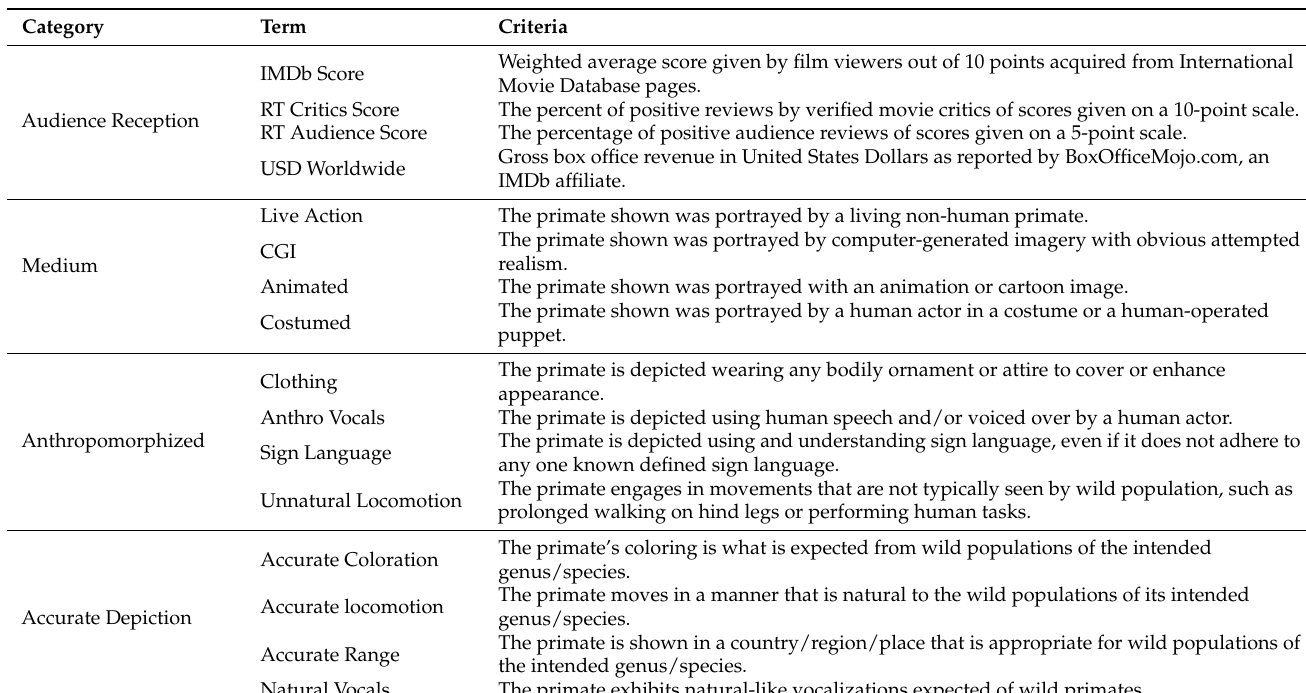
Table A1. Categories used for the data collection on English-speaking films that portrayed